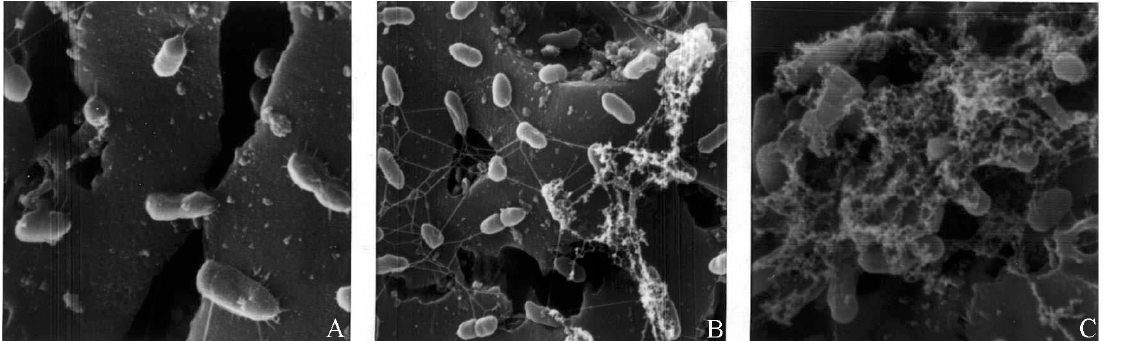
FIGURE 3. Biofilm formation of S. marcescens on activated carbon. (a) 3 h (b) 24 (c) 72 h.